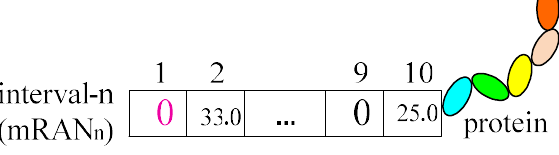
Figure 7. Protein Figure 7. Protein synthesis. Figure 7. Protein synthesis. Figure 7. Protein synthesis.